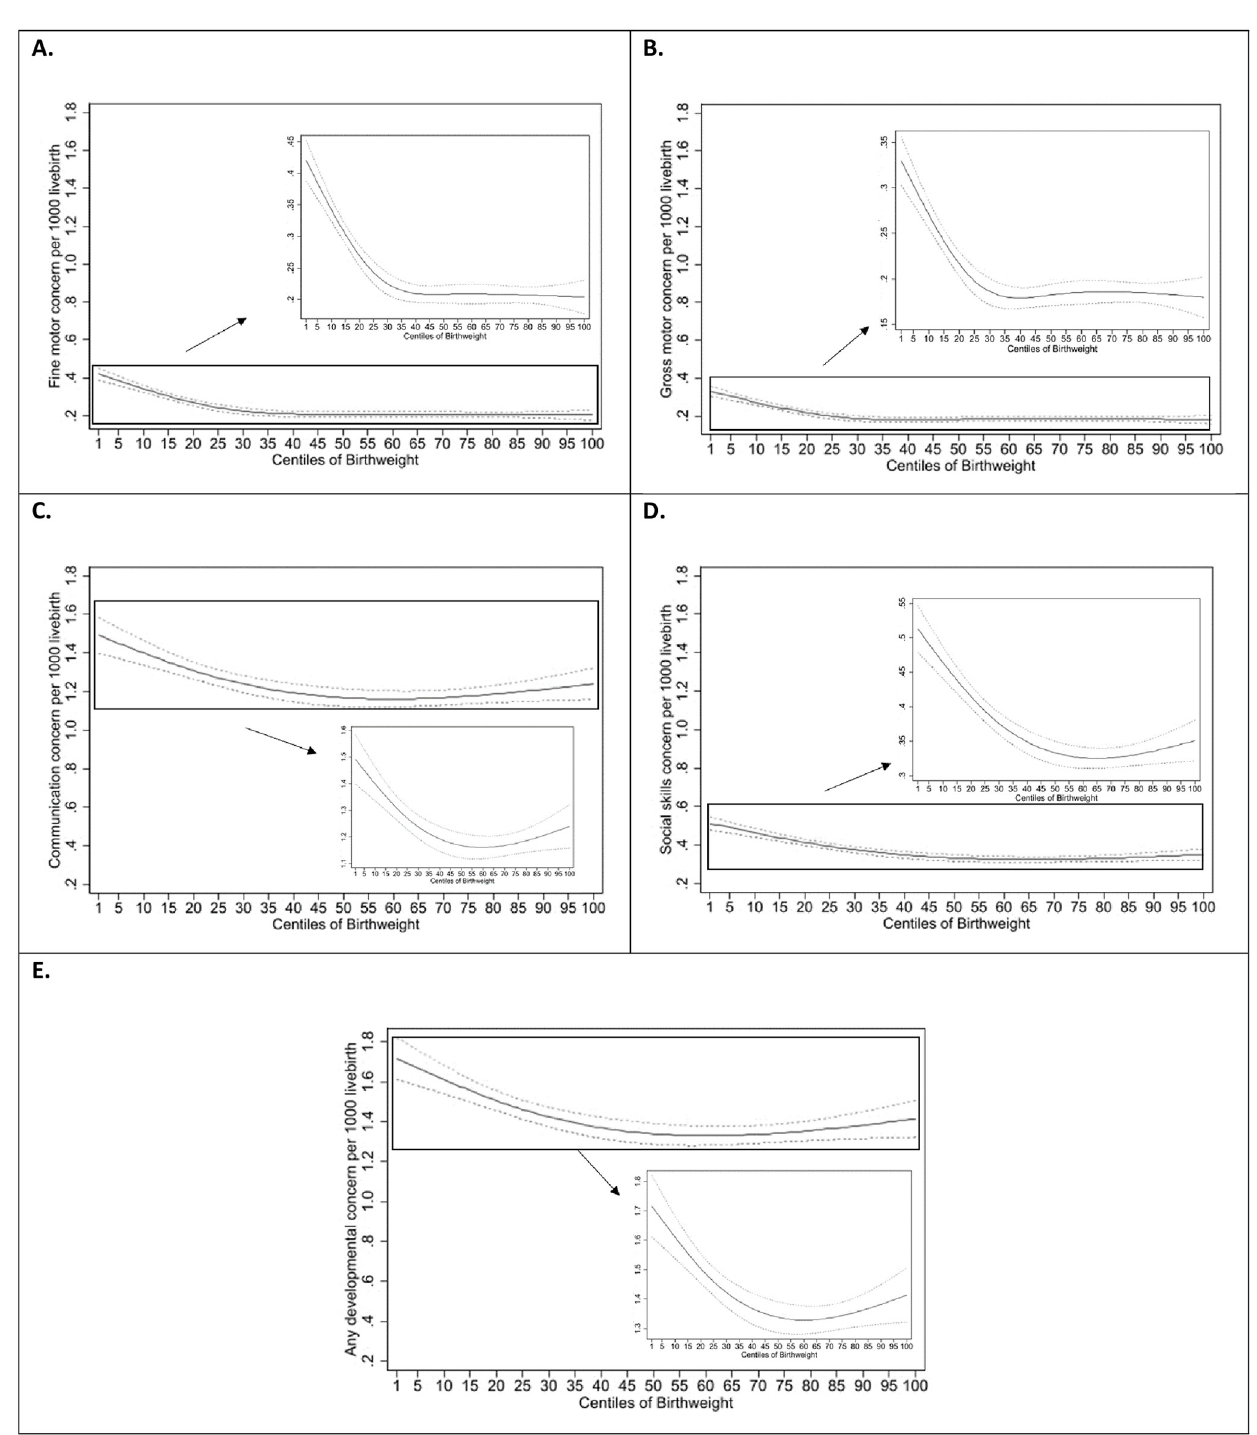
Fig 2. Regression splines showing child developmental concerns relative to birthweight centiles. The bold lines represent the predicted occurrence of developmental concerns, and the dotted lines represent the 95% confidence interval. (A) Restricted cubic spline showing predicted relationship between birthweight centiles and fine motor concern. (B) Restricted cubic spline showing predicted relationship between birthweight centiles and gross motor concern. (C) Restricted cubic spline showing predicted relationship between birthweight centiles and communication concern. (D) Restricted cubic spline showing predicted relationship between birthweight centiles and social skills concern. (E) Restricted cubic spline showing predicted relationship between birthweight centiles and any developmental concern.